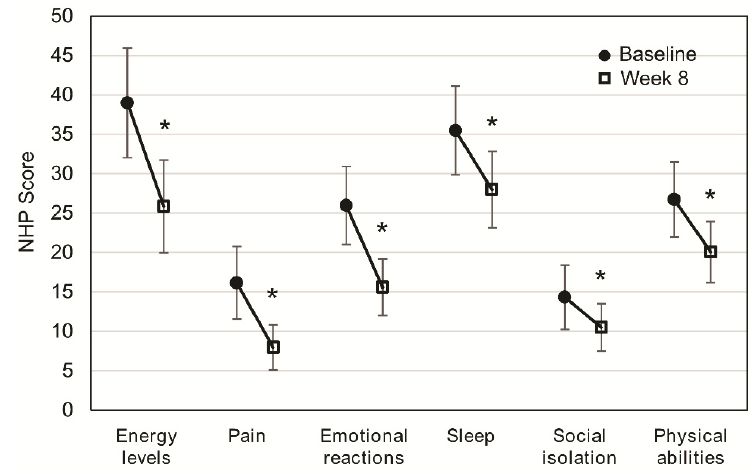
Figure 1. Change in quality of life after 8 weeks of oligomeric enteral nutrition (OEN). The plots show mean scores ± 95% CI for each category of the Nottingham Health Profile at baseline and after 8 weeks of OEN treatment. * indicates p < 0.05 (from baseline to Week 8). The Nottingham Health Profile (NHP) score ranges from 0 (does not perceive any health problem) to 100 (maximum health problems perceived by the patient).